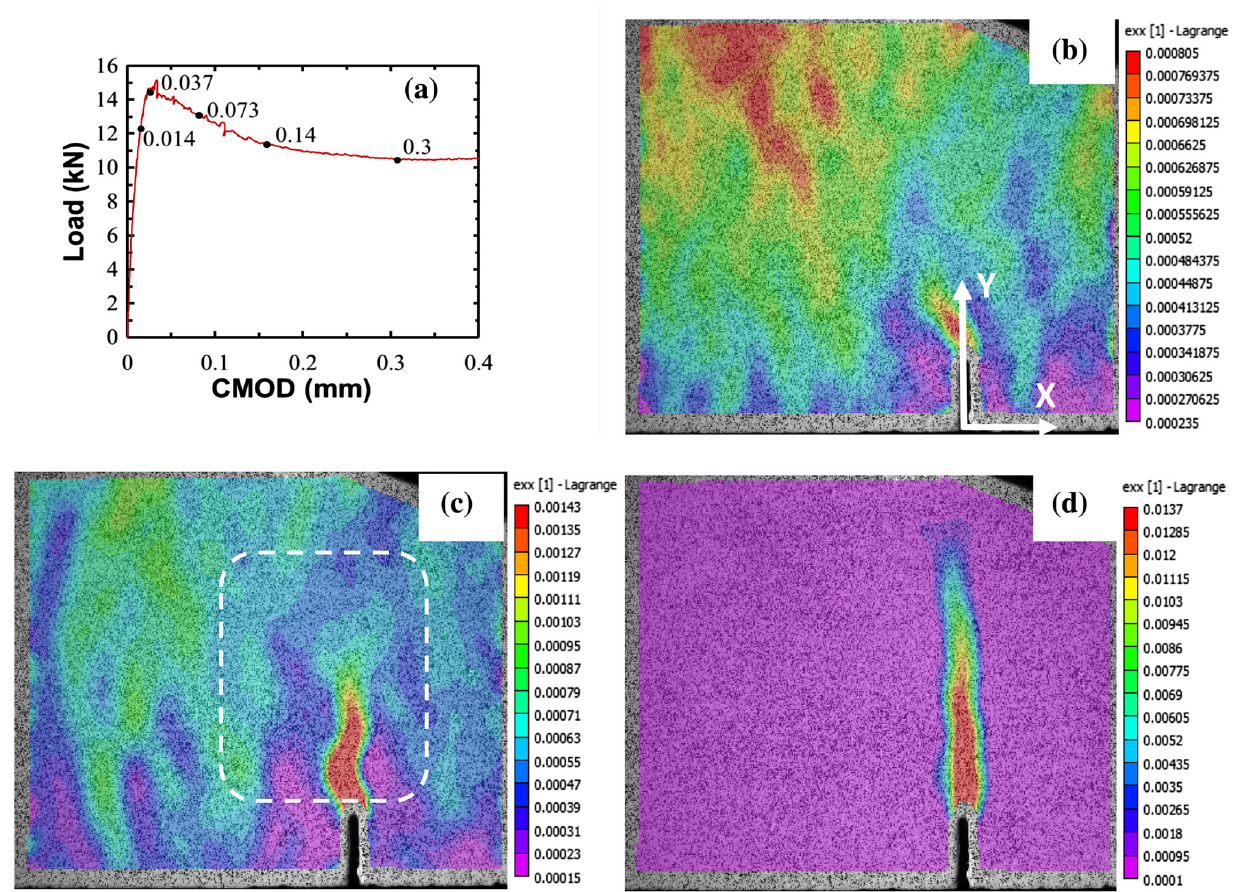
Fig. 3 a Load CMOD response of SFRC specimen with V f = 0.5%; Contours of e xx at b Load Point 1 (CMOD = 0.014 mm); c Load Point 2 (CMOD = 0.037 mm), d Load Point 5 (CMOD = 0.3